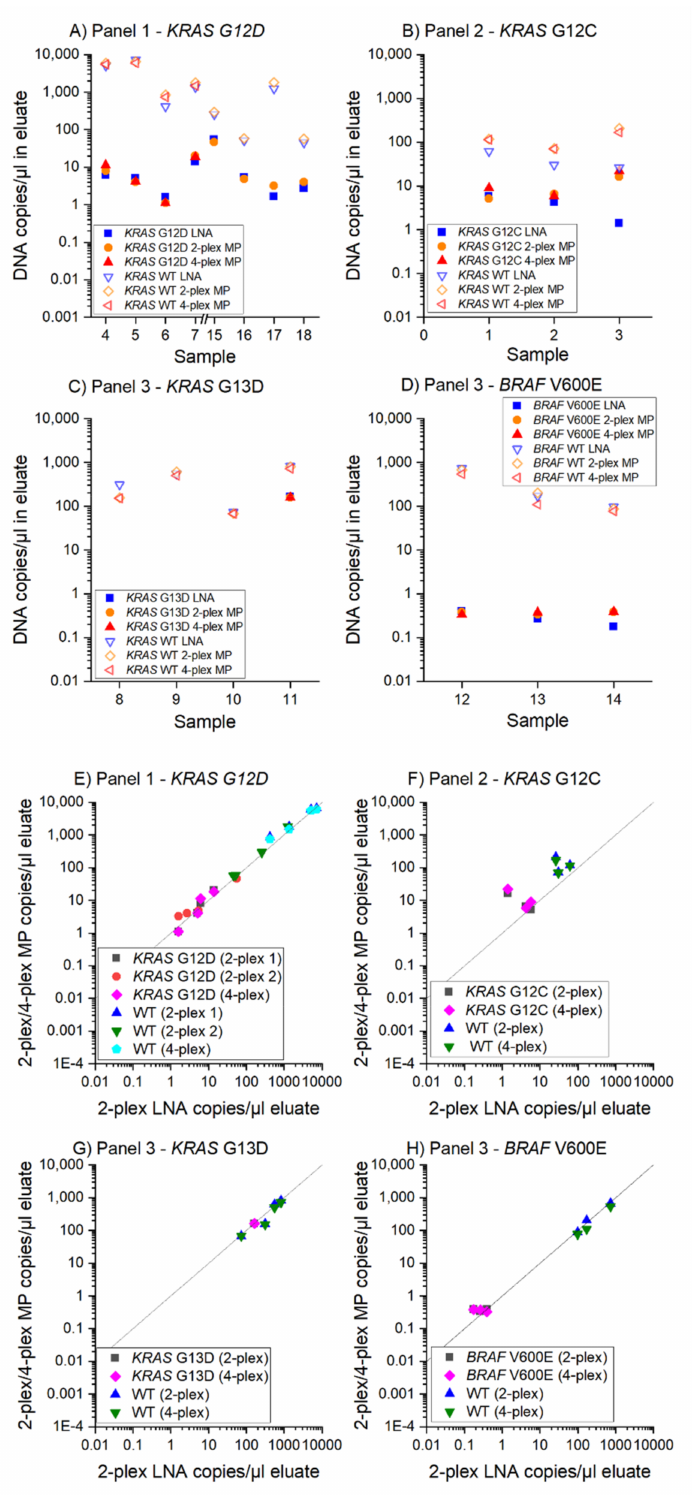
Figure 3. MP ddPCR assay validation with patient samples. The 2-plex and 4-plex MP ddPCR assays were compared to the 2-plex LNA reference assays. Wild type and mutant measurements are shown for four point mutations ( KRAS G12D, G12C, G13D, and BRAF V600E) in 18 different patient samples. ( A – D ) DNA copies/ µ L in the eluate for reference and MP ddPCR assays, ( E – H ) Evaluation of 2-plex and 4-plex MP ddPCR and reference assay. The deviation of the data for KRAS G12C in ( B , F ) could result from the different measurement time points (LNA measurements in 2019, MP measurements in